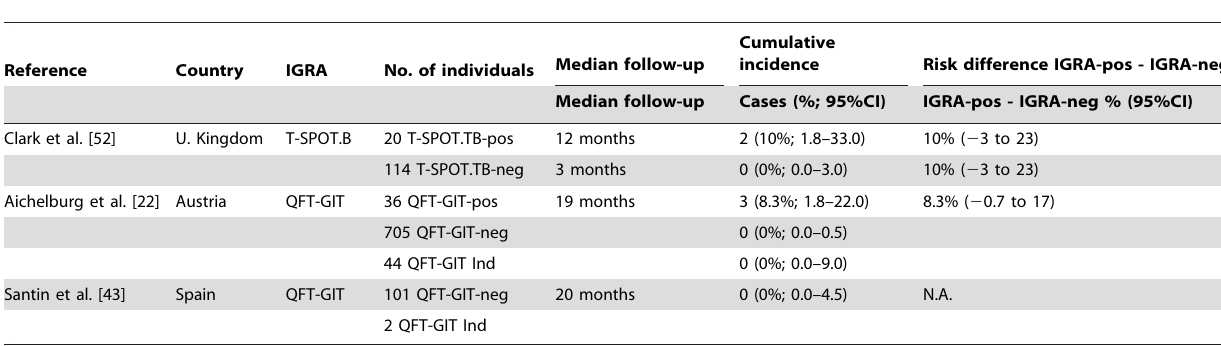
Table 5. Risk of active tuberculosis according to IGRA result in patients not receiving preventive treatment.